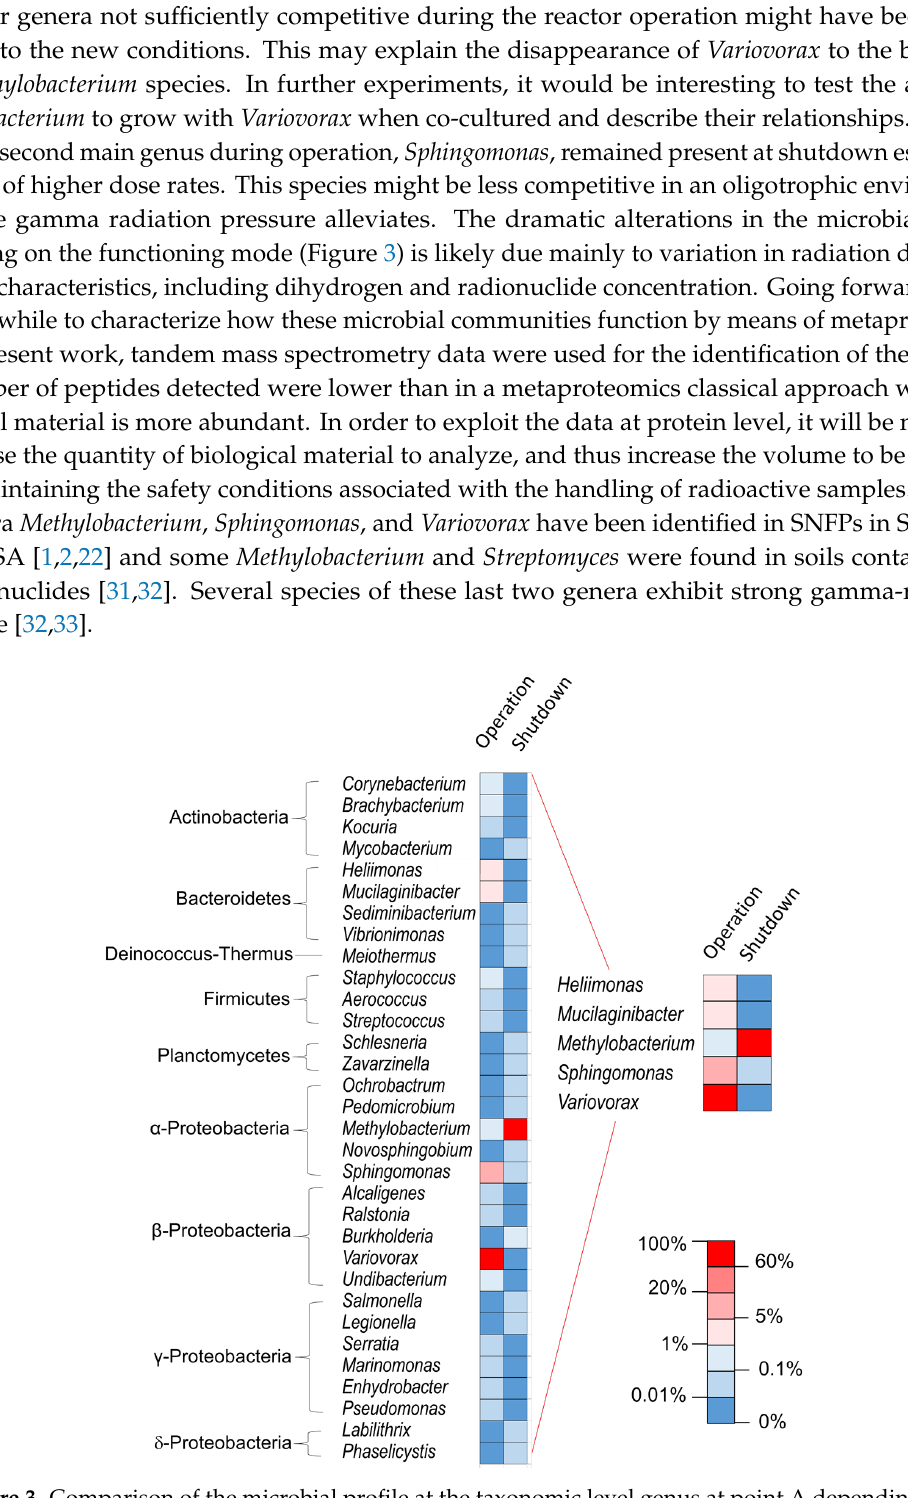
Figure 3. Comparison of the microbial profile at the taxonomic level genus at point A depending on the functioning mode, analyzed by metabarcoding. Mean taxon abundance obtained by the different methods (see Materials and Methods section).